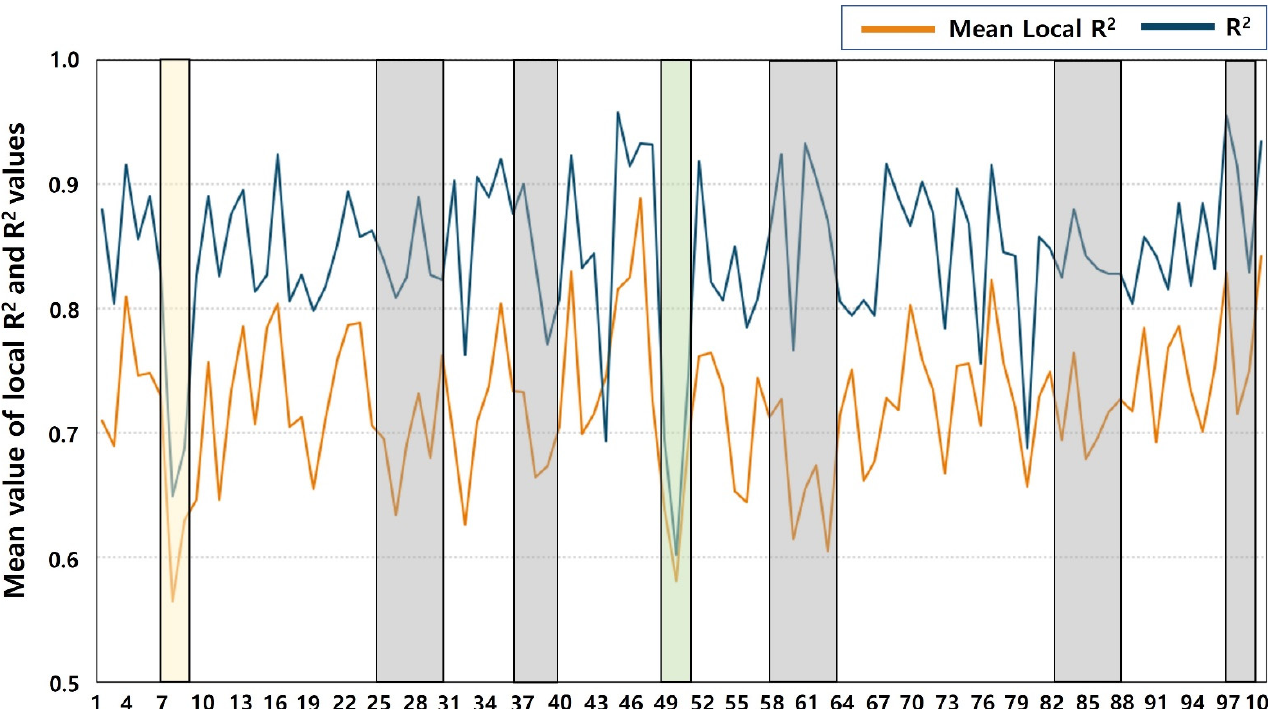
Figure 2. Results of monthly mean local R 2 and R 2 values of GWR without the temporal bandwidth during June 2009–October 2017. The yellow box represents the coldest winter in Europe during 2009–2017. The green box represents August 2013, the second hottest year without an El Niño since 1850 [35]. Grey boxes indicate the months showing the largest discrepancy between local R 2 and R 2 during 2009–2017.